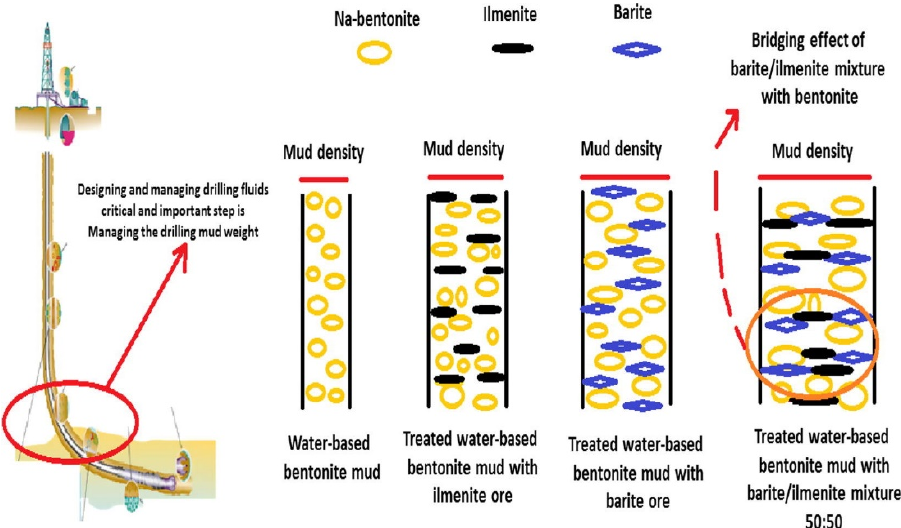
Figure 6. Schematic diagram of the mud weight bridging effect using bentonite, ilmenite, and barite [85].